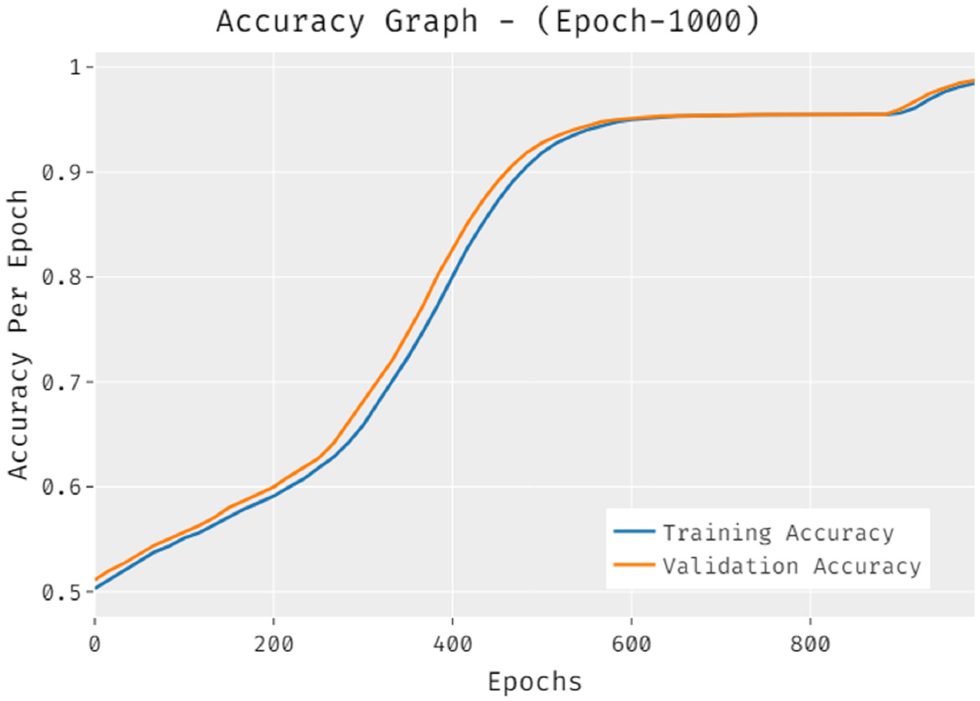
Figure 7. Accuracy graph analysis of DLSODC ‐ GWM technique under 1000 epochs.